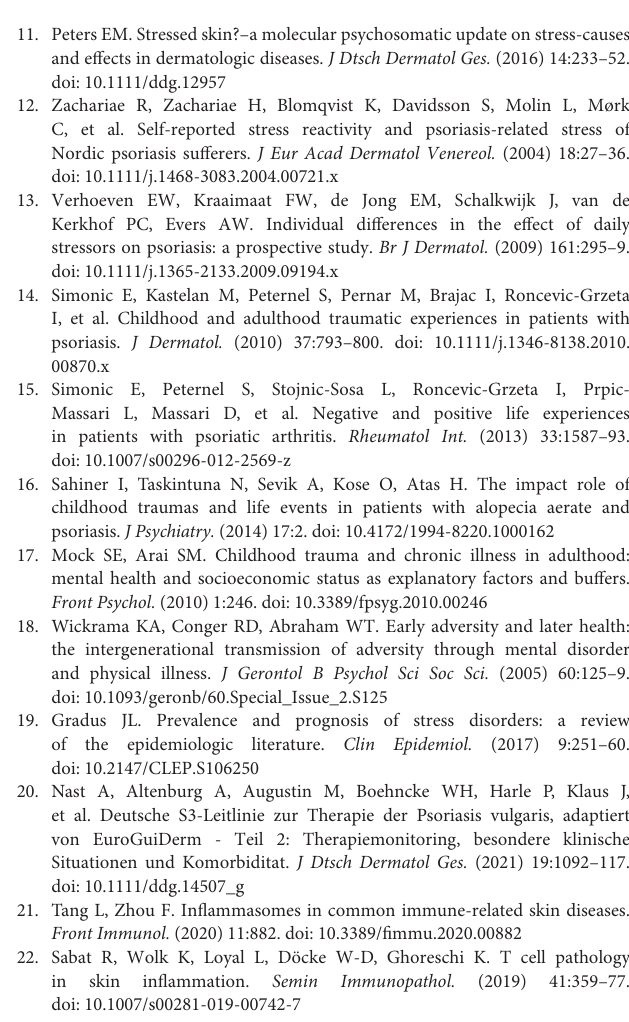
Supplementary Figure S4 | Displayed are the data for visualizing the conditional effect of the predictor Delta SAPASI on Delta DLQI, depending on the perceived stress (PSS) at T1. Z-standardized values were used. PSS = Perceived Stress Scale; SAPASI Self-administered Psoriasis Area and Severity Index. Supplementary Table S1 | Drop-Out analysis. Comparison between patients with psoriasis (PSO) (included in the final analyses) and drop outs (not followed-up at T2). For continuous variables medians and interquartile ranges (IQR) are presented. Bold values indicate significance at p ≤ 0.05. Supplementary Table S2 | Correlation analyses between CTQ subscales and psoriasis severity (PASI, SAPASI, BSA). Displayed are Spearman’s rho correlation coefficients and p -values (in brackets). Supplementary Table S3a | Results of the hierarchical regression analysis to assess the effect of the variables age, gender, Delta SAPASI (step 1), PSS ‘perceived stress’ at T1 (step 2) and the interaction Delta SAPASI (T1) × PSS ‘perceived stress’ (step 3) on the treatment outcome (Delta DLQI). Sample size: n = 52 patients with complete data. Bold values indicate significance at p ≤ 0.05. Supplementary Table S3b | Results of the hierarchical regression analysis to assess the effect of the variables age, gender, Delta SAPASI (step 1), CTQ total at T1 (step 2) and the interaction Delta SAPASI (T1) × CTQ total (step 3) on the treatment outcome (Delta DLQI). Sample size: n = 58 patients with complete data. Bold values indicate significance at p ≤ 0.05.